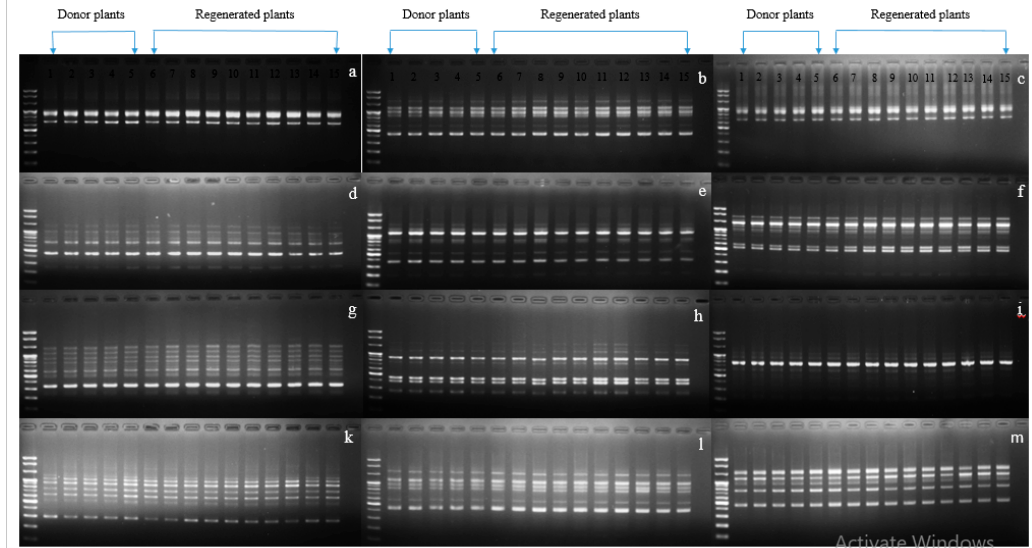
Figure 6. Showing genetic stability between vitrified-derived plants and donor plants using random amplified polymorphic DNA (RAPD) markers in cultivar Kumbuyl (KB). ( a ) OPA 03, ( b ) OPA 04, ( c ) OPA 07, ( d ) OPA 10, ( e ) OPA 19, ( f ) OPB 01, ( g ) OPB 17, ( h ) OPA 01, ( i ) OPA 02, ( k ) OPB 06, ( l ) OPB 07, ( m ) OPB 10.